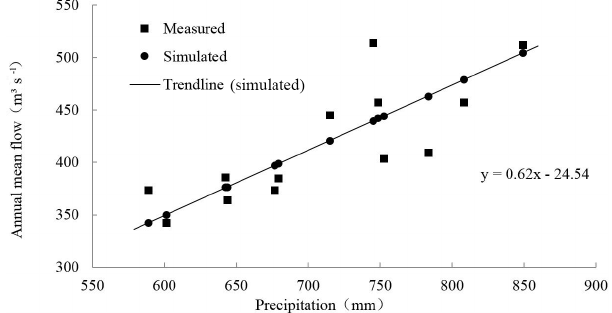
Figure 4. Comparison of simulated r and measured annual mean flow from 1996 to